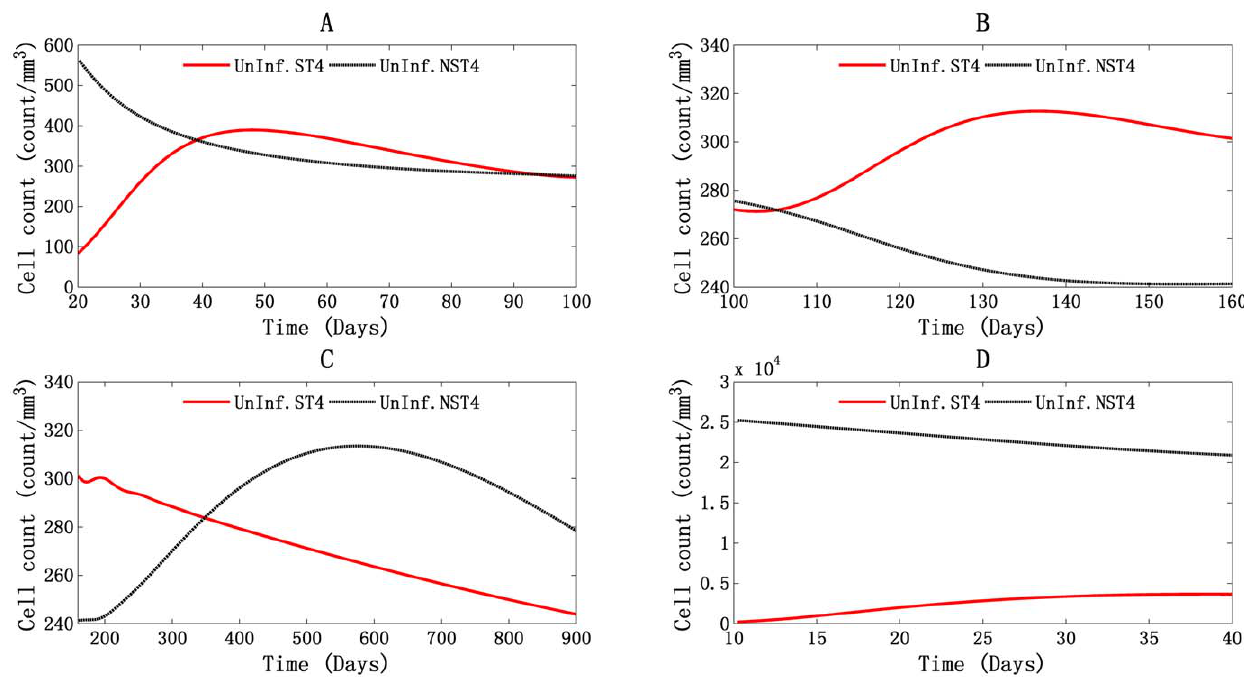
and (C) from day 160 to day 900.